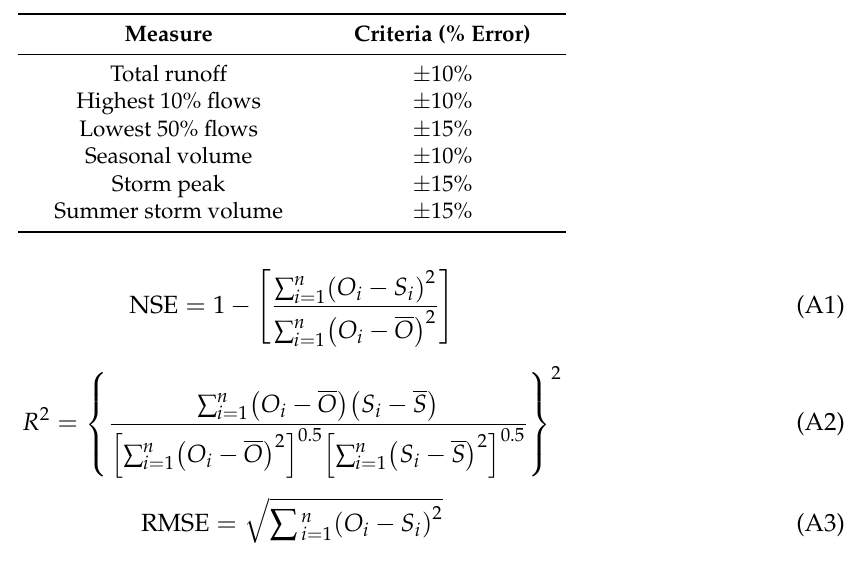
Table A1. Performance variables and criteria of the HSPEXP method